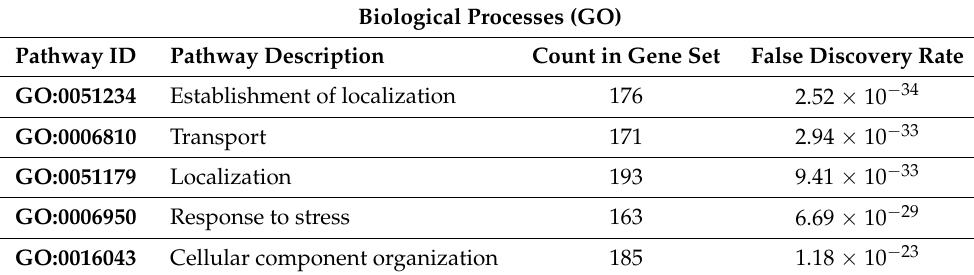
Table 3. Gene Ontology (GO) analysis of biological